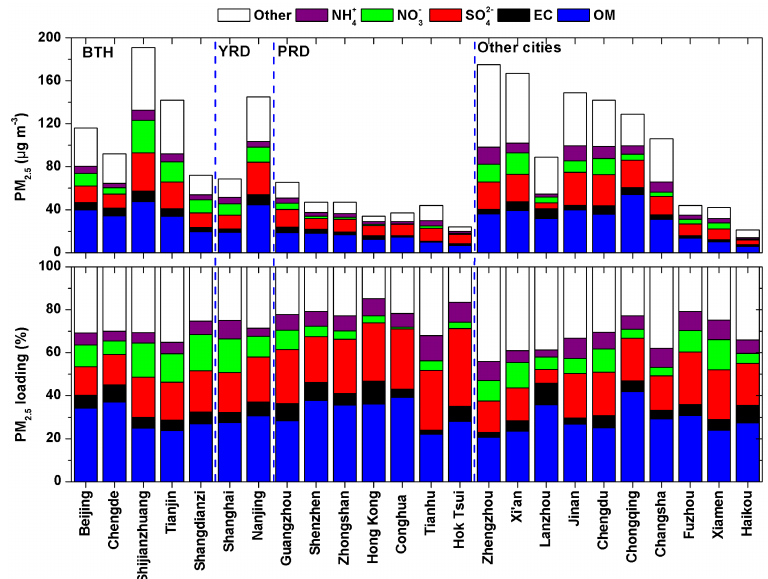
Figure 8. Annual PM 2 . 5 and dominant chemical components in China.